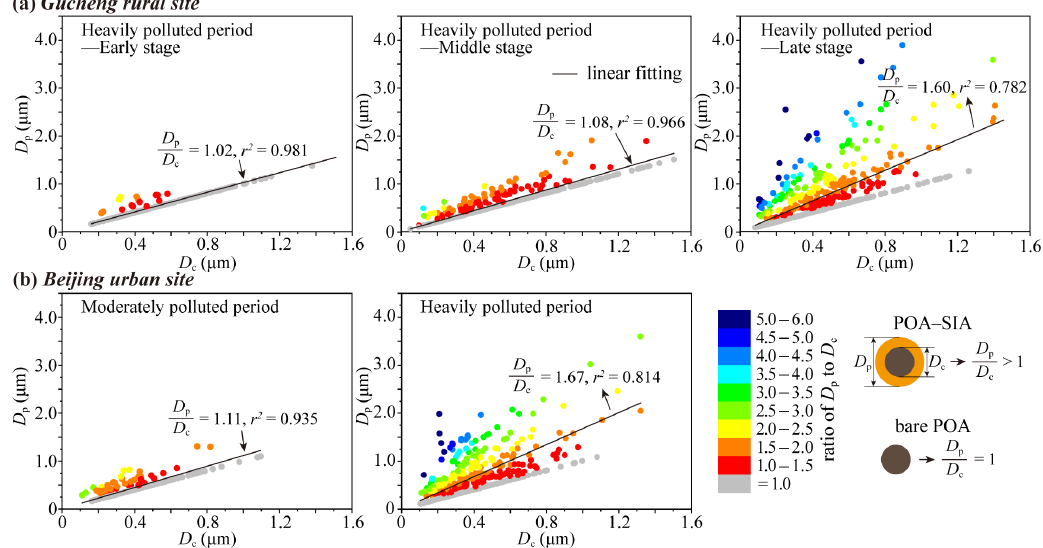
Figure 8. Relationship between the diameter of a POA-containing particle ( D p ) and its POA core ( D c ) in the early stage, middle stage, and late stage of the heavily polluted period at the Gucheng rural site (a) and in the moderately polluted and heavily polluted periods at the Beijing urban site (b) .